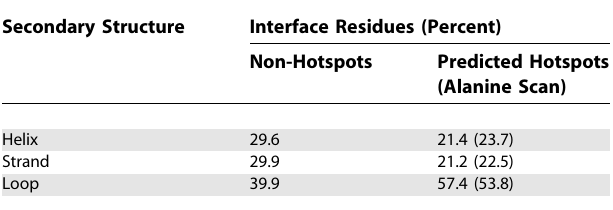
Table 2. Secondary Structure in Hotspots versus the Rest of the Interface